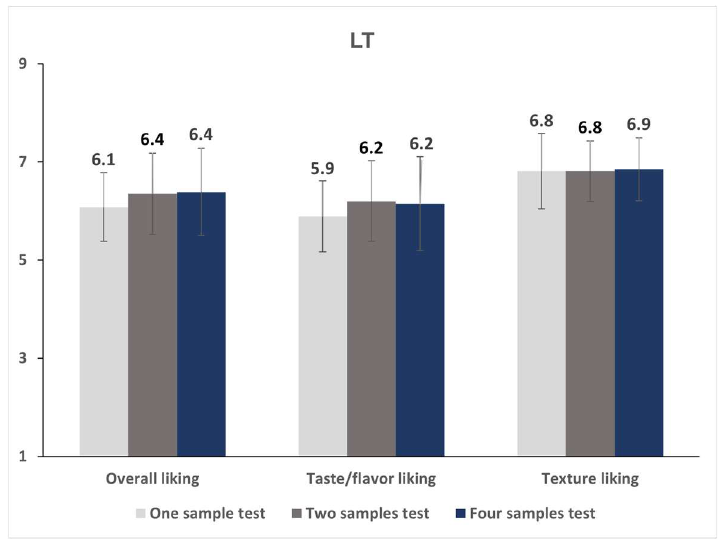
Figure 4. Mean liking scores of the almond beverage test target sample according to the number of evaluation samples in the lab condition test.